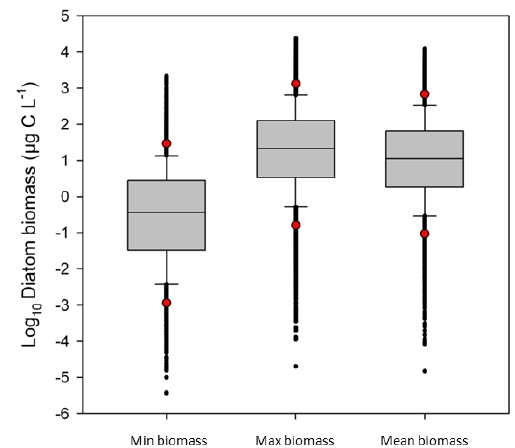
Figure 10. Boxplot of the minimum, maximim and mean estimates of diatom biomass (log 10 µ gCl1 − 1 ). Red dots represent the 5th and 95th percentiles and black circles the